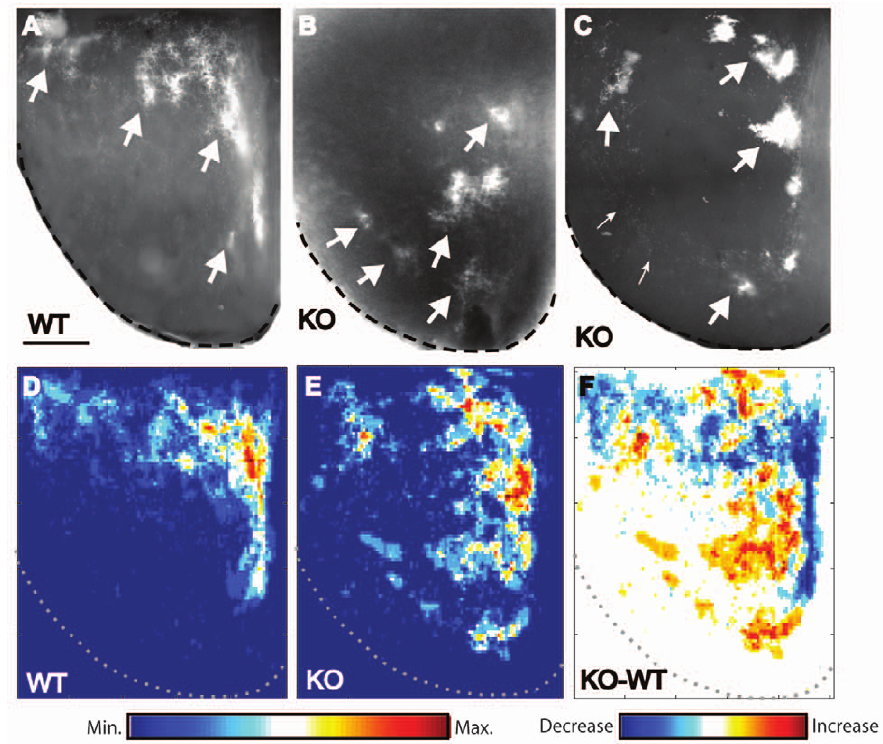
Figure 5. Ten-m3 is required for targeting of ipsilateral axons to rostromedial SC. A–C: Horizontal sections through the SC following injection of CTB into the ipsilateral eye from WT (A) and Ten-m3 KO (B, C) mice. Rostral is to the top and medial to the right in all images. In WTs, ipsilateral terminals form clusters that are confined almost entirely to rostromedial portions of the SC (A). Ipsilateral terminals are clustered but are much more widely distributed in Ten-m3 KO mice. In B, terminals largely avoid rostral SC and are seen in mid and even in caudolateral SC. A less extreme case is shown in C. Here, ipsilateral terminals do target rostral SC, but are also seen in more caudal and lateral areas that do not receive ipsilateral innervation in WTs. Some larger clusters of terminals are highlighted by large arrows. Small arrows point to smaller clusters of ipsilateral terminals that were seen in caudolateral SC in some KO cases. D–F: Heat-maps indicating overall distribution of ipsilateral label in WT and Ten-m3 KOs compiled across all cases. Rostral is to the top and medial to the right in all images, with dashed lines delineating the borders of the SC. The distribution in WTs is highly stereotyped with label concentrated in rostromedial areas (D). In Ten-m3 KOs ipsilateral terminals are much more widely distributed (E), with clusters seen in more caudal and lateral regions compared to WTs. A subtraction of the WT and KO heat-maps is shown in F to give a clear view of the location and direction of change. Colour bar (D, E): Relative intensity of labelling; Colour bar (F): Difference in intensity between WT and KOs; Scale in A: 500 m m, applies to